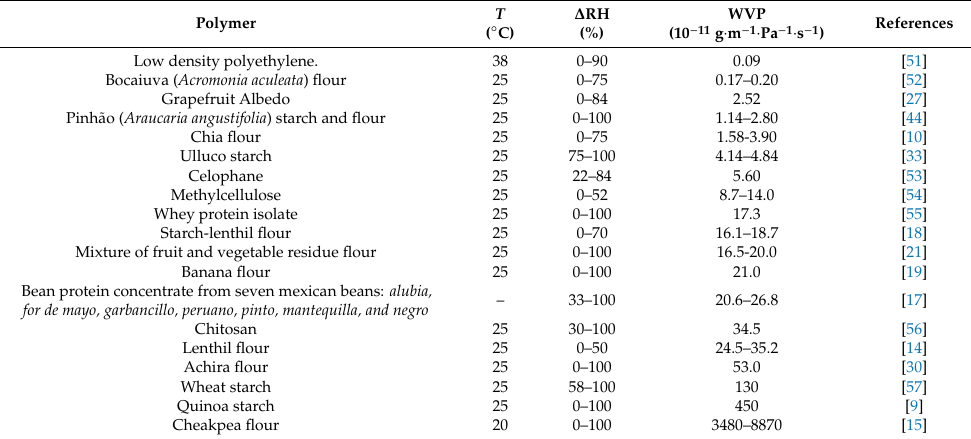
Table 1. Water vapour permeability (WVP) of selected biopolymer and plastic films.